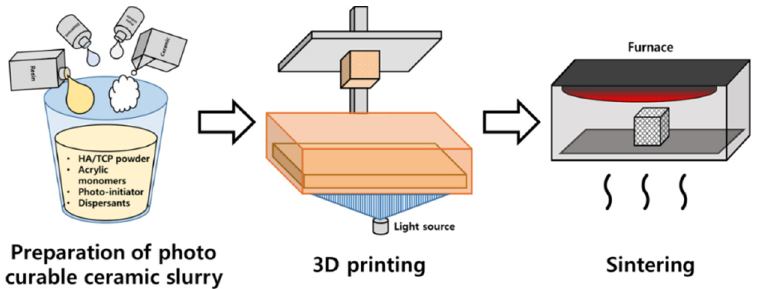
Figure 4. The overall procedure of 3D-printed pure ceramic scaffold